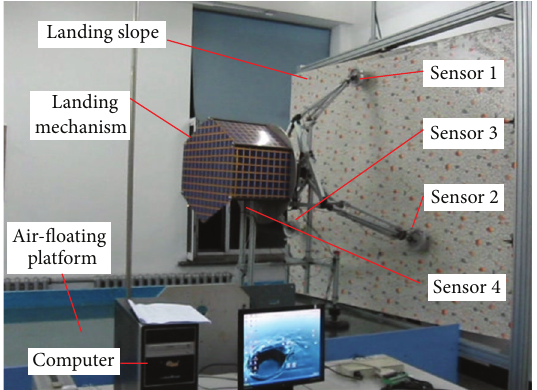
Figure 8: Landing mechanism on the air-floating